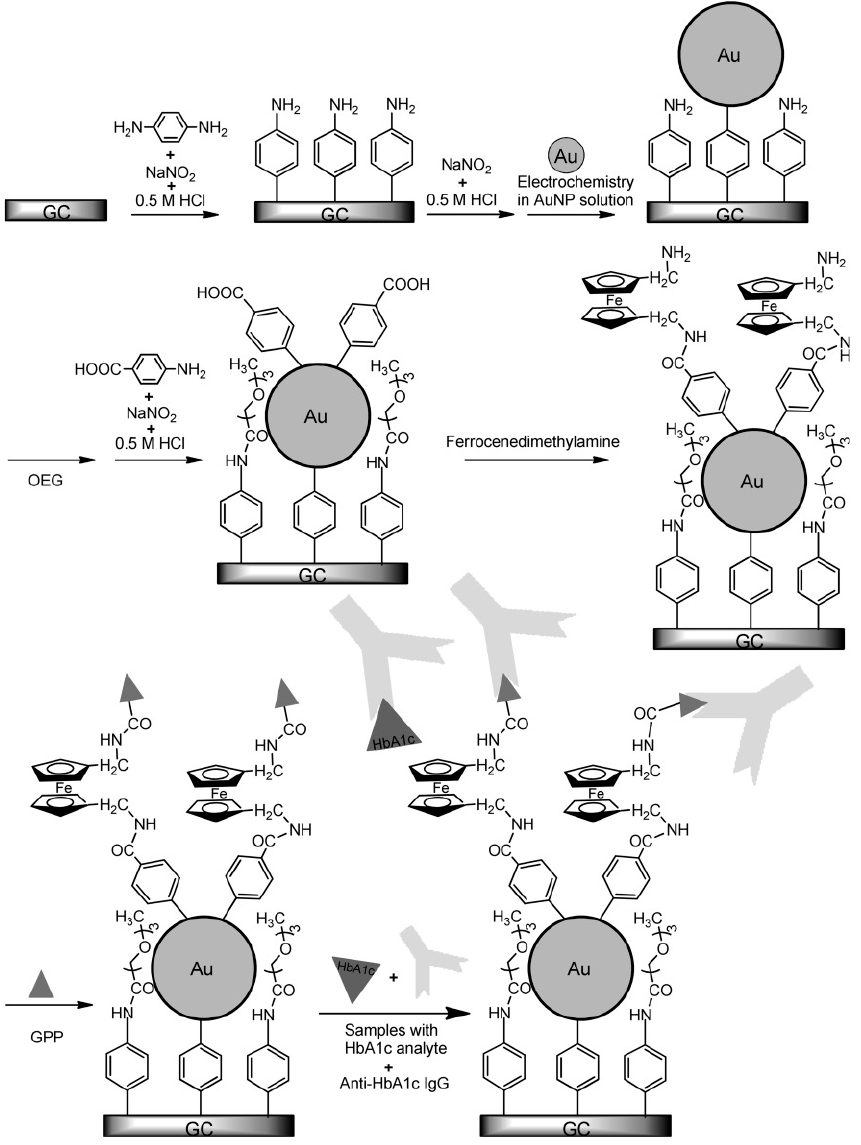
Figure 5. Immunosensor established by Liu et al. summarizes AuNP-assisted amperometric detection of HbA1c. Reprinted with permission from [52].